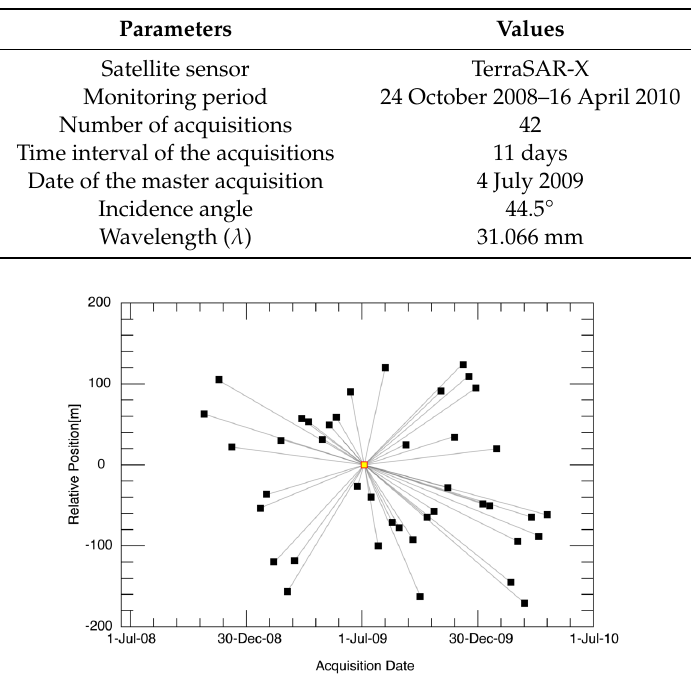
Figure 9. The combination of the interferometric pairs used in the PSI approaches. The yellow square shows the master acquisition, and the black squares are the slave acquisitions. The horizontal axis shows the date of the acquisition, the vertical axis shows the baseline length in meters, and the gray lines show the combination of the interferometric pairs.